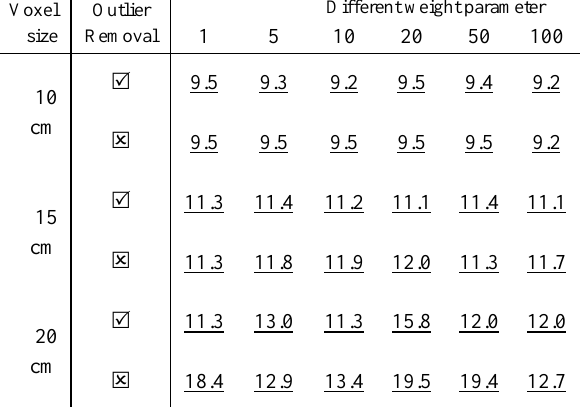
Table 1- Average distance between source and registered cloud for different parameters Voxel Outlier